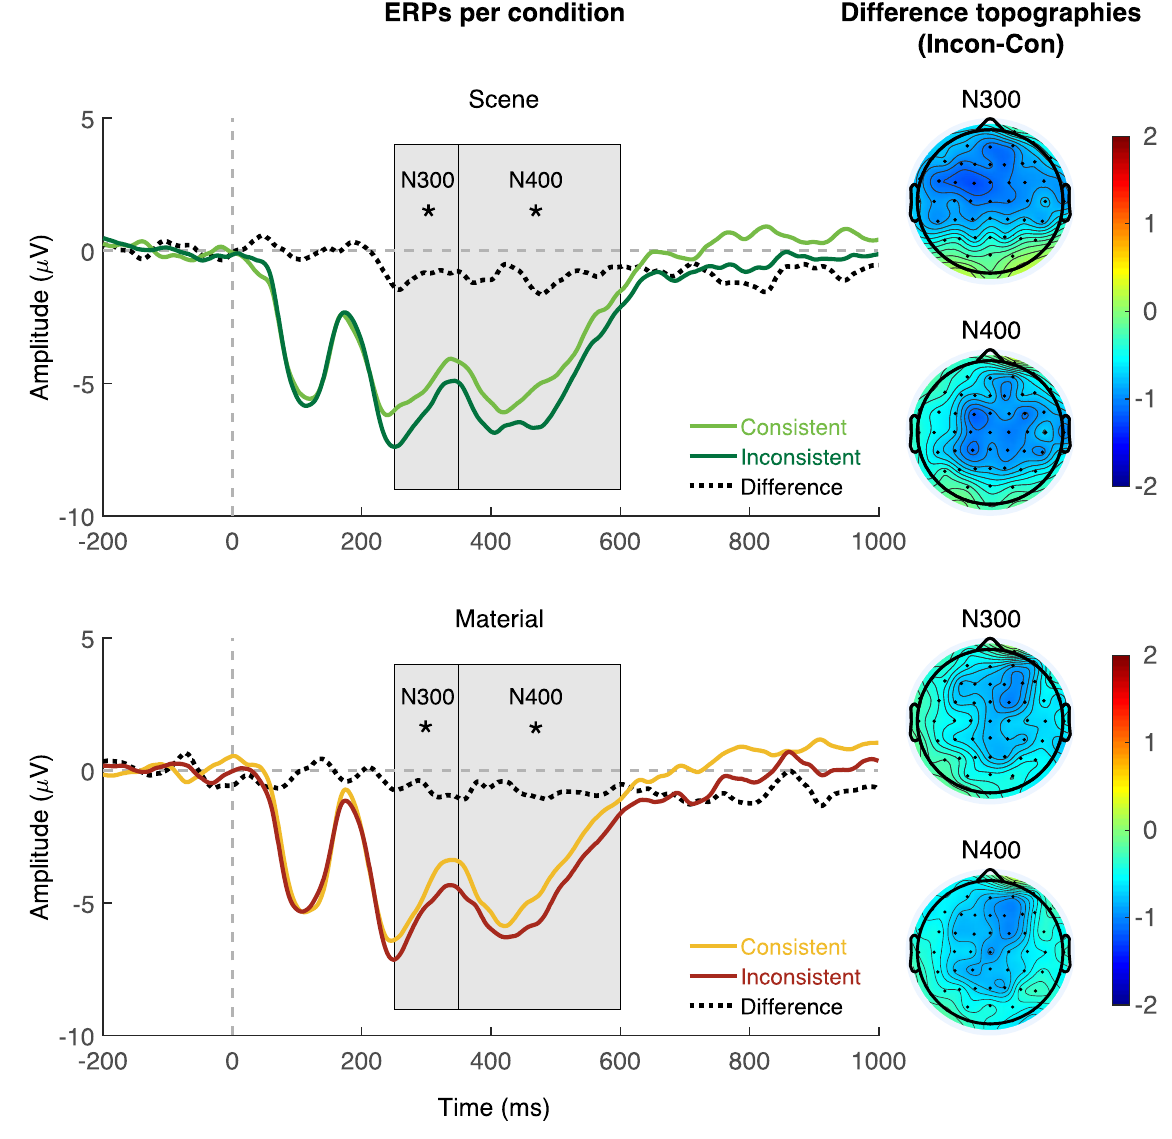
Figure 3. Grand-averaged ERPs for the mid-central region (electrodes FC1, FCz, FC2, C1, Cz, C2, CP1, CPz, CP2) for consistent versus inconsistent objects on scenes (top panel) and materials (bottom panel), as well as corresponding difference topographies for inconsistent versus consistent objects in the N300 and N400 time